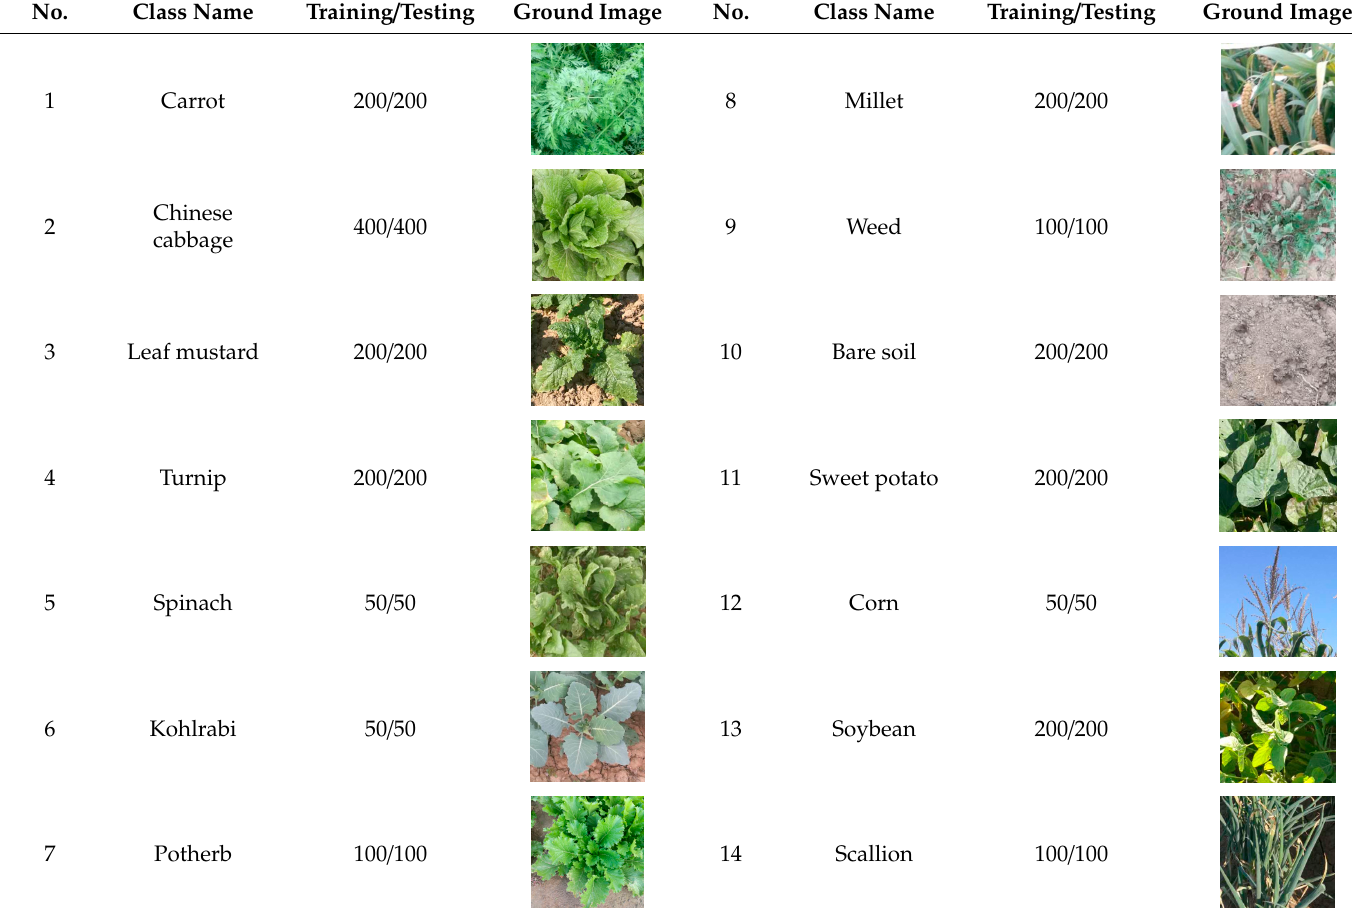
Table 1. Classification scheme of this study.